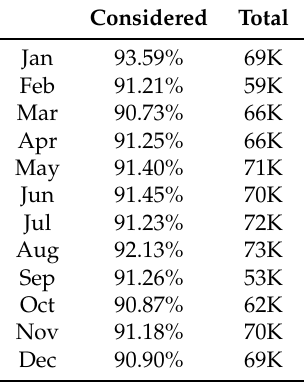
Figure 5. Estimation of lognormal parameters ˆ σ , ˆ µ , and the related p -value for the update frequency of the 1000 most popular Wikipedia pages in 2016. Table 2. Total and considered updates for the top 1000 Wikipedia pages in